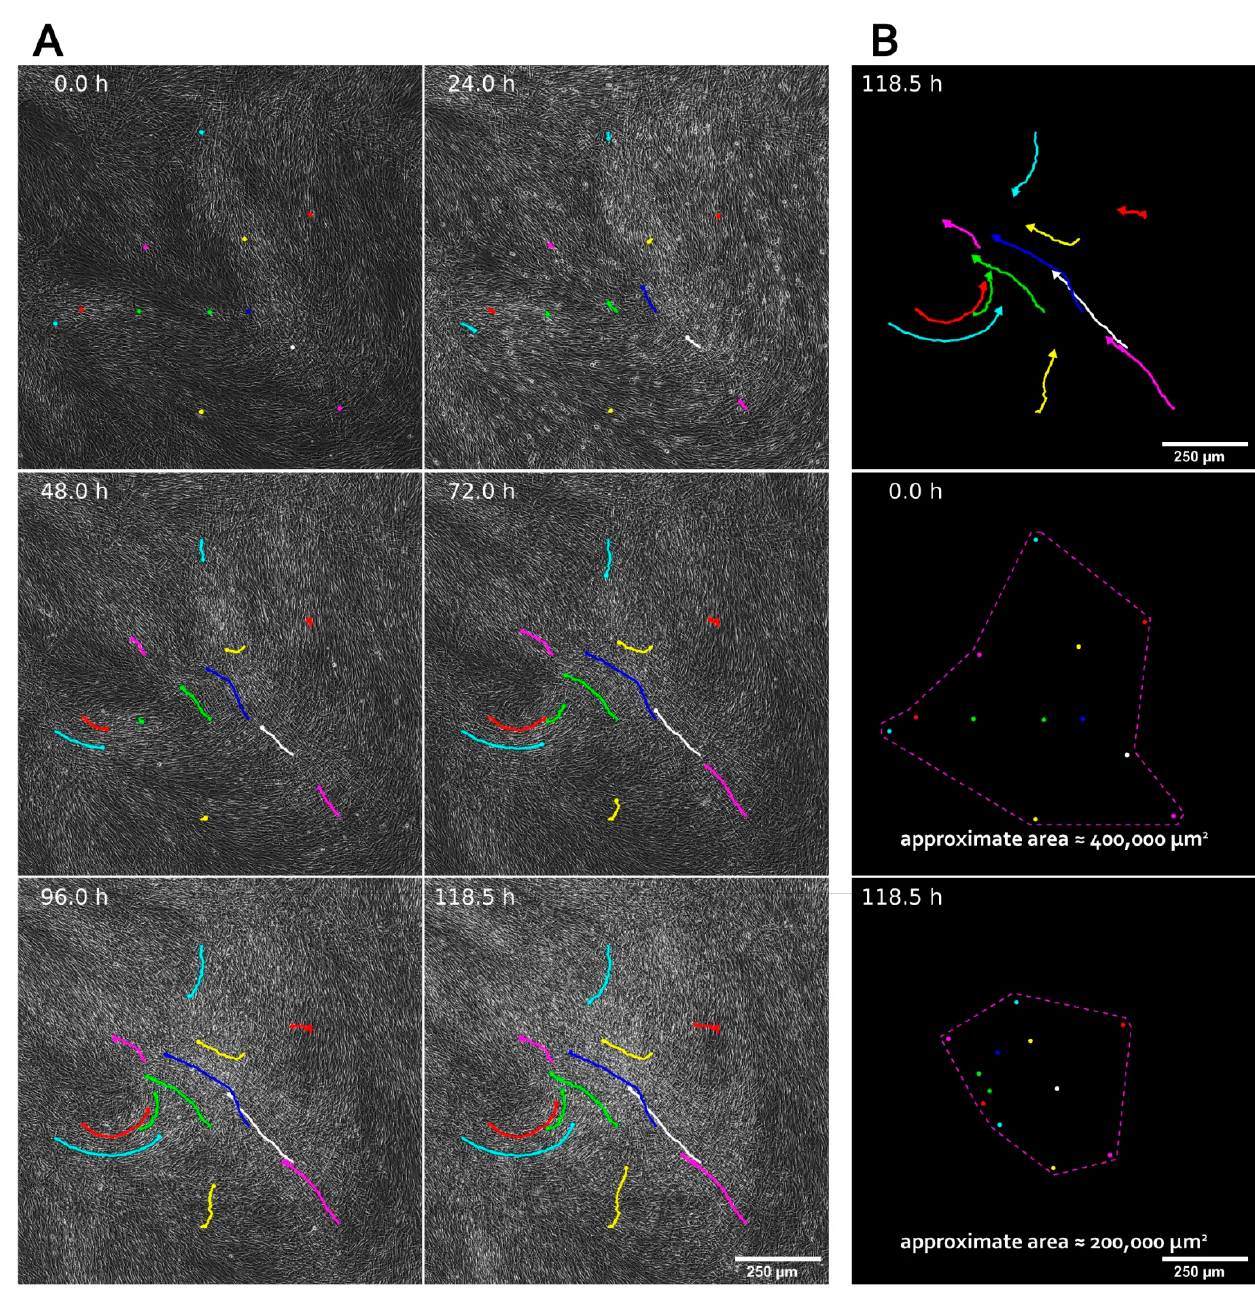
Figure 1. Formation of condensed areas in cell sheets by the spontaneous self-organization of MSC. ( A ) Time-lapse footage of MSC condensation during cell sheet assembly. Phase-contrast microscopy, magnification ×100. Colored dots mark randomly selected cells at the starting point of the observation (0 h), and colored tracks mark their migration during 120 h of experiment. ( B ) Plotted tracks of selected MSC during cell sheet assembly and the analysis of compaction by measurement of the surface area between the most distant selected dots, which decreased approximately 2-fold upon completion of the experiment.